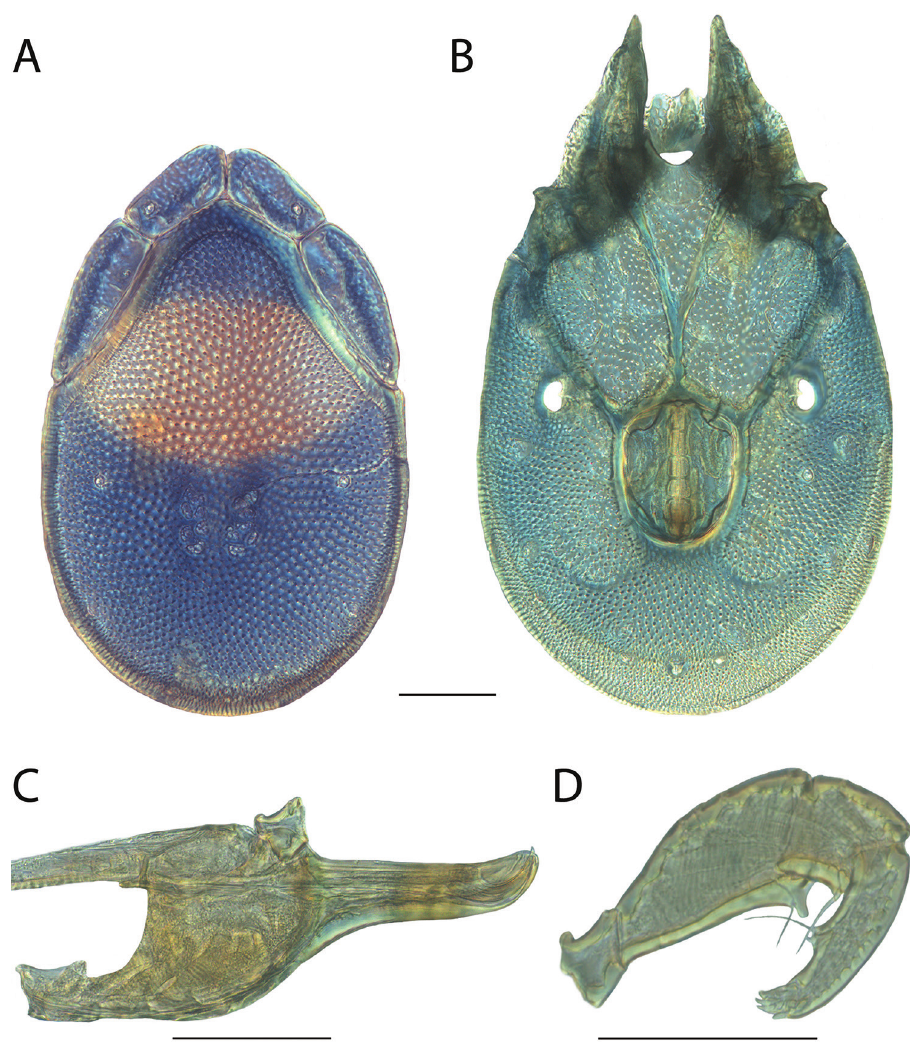
Figure 92. Torrenticola gorti sp. n. male, Tennessee specimen depicted: A dorsal plates B venter (legs removed) C subcapitulum D pedipalp (setae not accurately depicted). Scale = 100 µm.